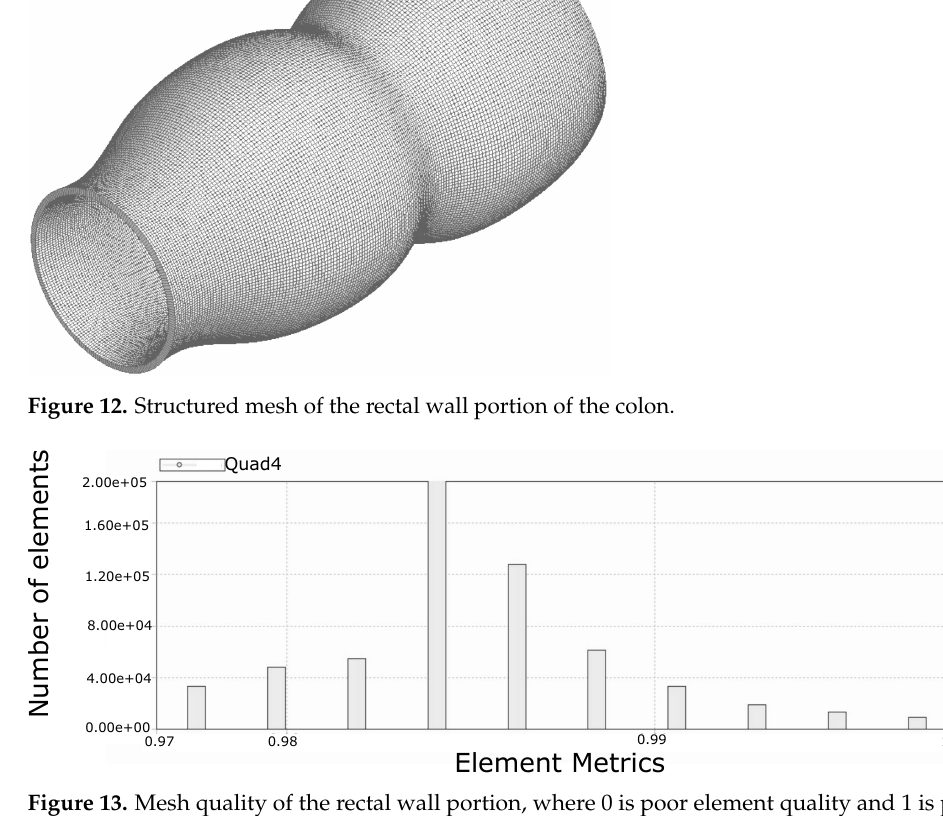
Figure 13. Mesh quality of the rectal wall portion, where 0 is poor element quality and 1 is perfect element quality. The absence of elements with a quality lower than 0.97 accounted for an adequate reticulation of the colon wall, which allowed adequately representing the deformation of the material. Note: Quad4 is the type of element used by the mesh and represents a quadrilateral with 4